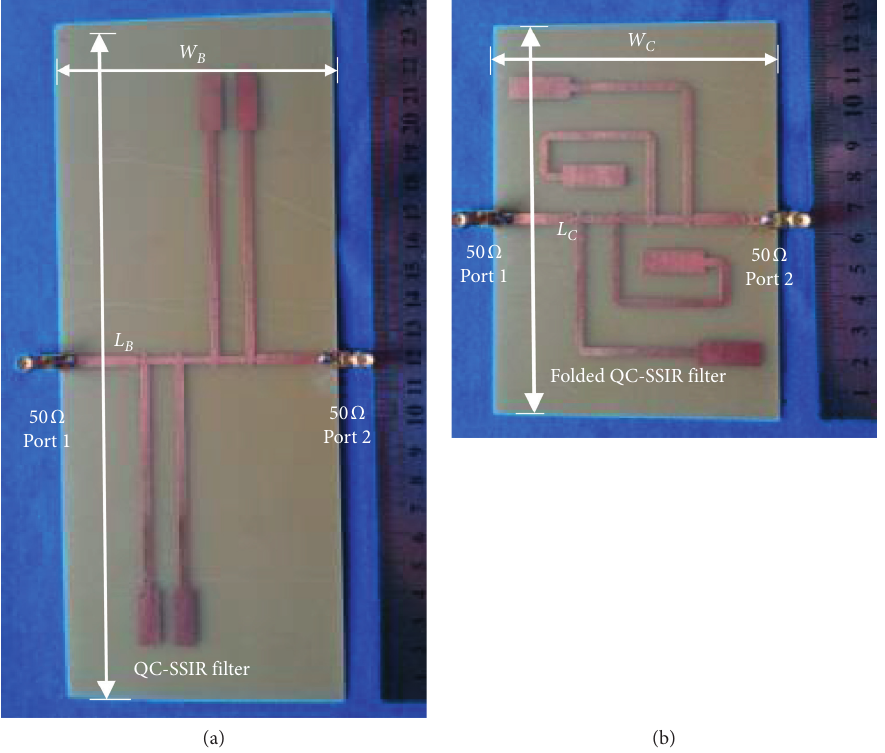
Figure 12: Photograph of MW-BPFs using a (a) QC-SSIR and (b) FQC-SSIR.